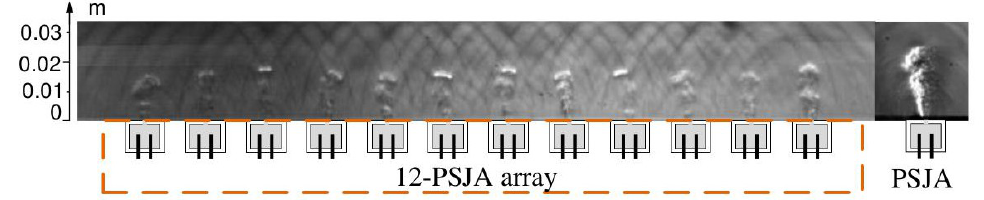
Figure 13. Schlieren images of 12-SparkJet array and single SparkJet. Reprint from [54] with permis- sion from